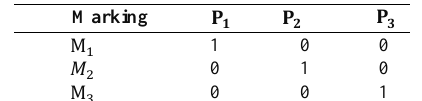
Table 1. Reachable marking obtained figure 5.